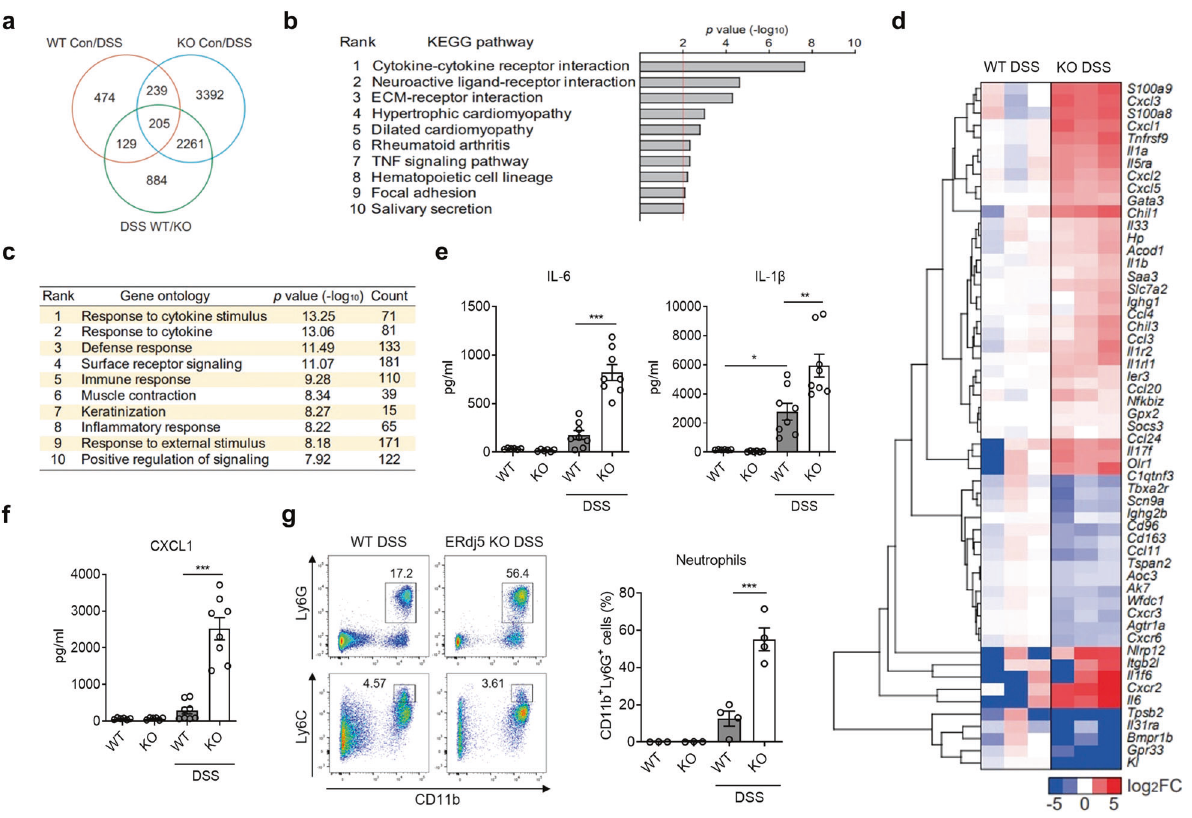
Fig. 2 RNA-seq reveals an altered gene expression pro fi le for in fl ammation in the absence of ERdj5. a Venn diagram. The number of differentially expressed genes (DEGs) from colon samples extracted from 8-week-old female WT or ERdj5- KO mice ( n = 3 per group) treated with or without 2% DSS. b KEGG pathway analysis of DEGs in colon samples extracted from 8-week-old female WT or ERdj5- KO mice ( n = 3 per group) treated with or without 2% DSS. Pathways with statistical signi fi cance ( P > 0.01) are shown. c GO analysis of major signaling pathways identi fi ed by RNA sequencing using the DAVID bioinformatics database. The top 10 pathways based on P values are shown, along with the number of genes with the respective ontology. d Heatmap of the DEGs associated with in fl ammation. The log 2 ratios of ERdj5 KO DSS/WT DSS are presented (blue, underexpression; red, overexpression). Values over 5 or under − 5 were rounded. e Levels of IL-1 β and IL-6 in colon homogenates ( n = 6 – 8 per group). f Level of CXCL1 in colon homogenates ( n = 6 – 8 per group). g Representative fl ow cytometric analysis of CD11b + Ly6G + neutrophils and CD11b + Ly6C + monocytes among pregated live CD45 + IA-IE - CD11c - cells in the LP of the colon. The percentage of CD11b + Ly6G + neutrophils is expressed as the mean ± SEM ( n = 3 – 4 per group). * P < 0.05, ** P < 0.01, *** P < 0.001; one-way ANOVA followed by Tukey ’ s